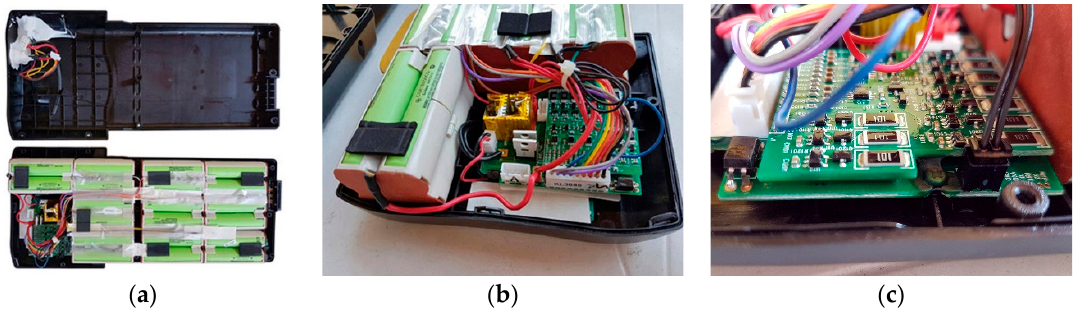
Figure 9. Disassembled battery pack ( a ), cells that produce the hot spots ( b ), a BMS circuitry ( c ). The battery pack structural analysis resulted in a circuit principal diagram, shown in Figure 10. The results can be summed up as follows: the battery pack consists of 40 cells Panasonic CGR18650CG type, cells nominal voltage is 3.6 V and nominal charge capacity of 2250 mAh, individual cell weight is 45 g [33]. The electrical connections arrangement was made in the form of ten cell blocks connected in series (10s), and each cell block consists of four parallel connected cells (4p)—a so-called the 4p10s battery cluster. The way cells are joined together is crucial for packet behavior [34,35]. The balancing leads connection points, for the sake of clarity, are marked with colored circles at the BMS and in between cellblocks. Each balancing line has temporally thermal overcurrent protection accomplished by Polymer PTC Resettable Fuse of JK-D Series; furthermore, the BMS has two additional thermal monitoring and protection probes.